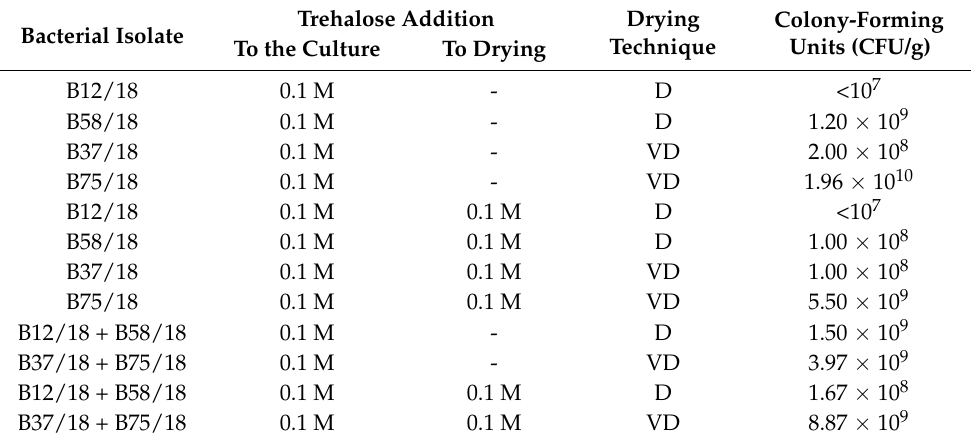
Table 4. The effect of trehalose addition and the chosen drying methods on bacterial survivability in drying (D) and vacuum drying (VD) processes used in manufacturing and in the naturalization biopreparation. Rhodococcus sp. B12/18, Pseudomonas sp. B37/18, Arthrobacter sp. B58/18, Rhodococcus sp. B75/18, D—drying, VD—vacuum